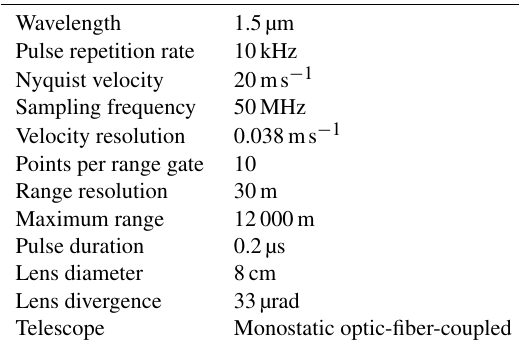
Table 2. Technical specification of the Halo Doppler